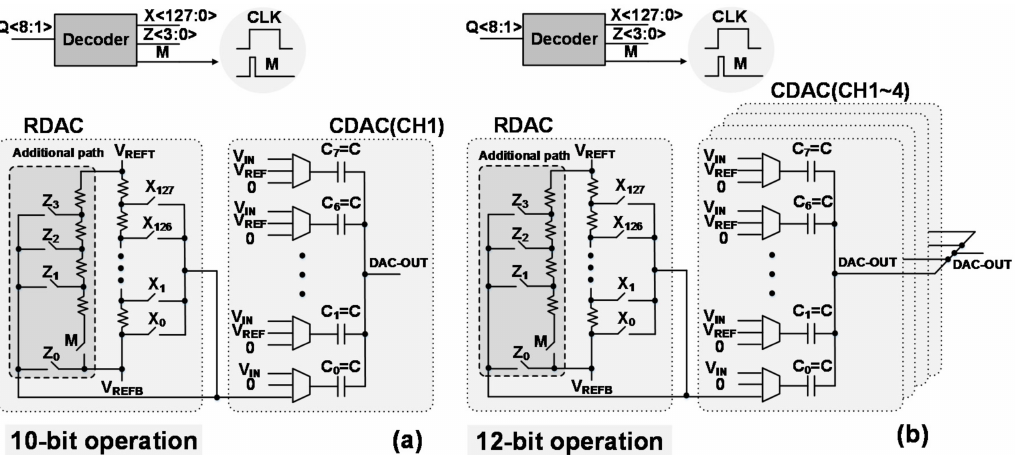
Figure 4. Simplified CDAC (capacitor digital-to-analog converter) and RDAC (resistor digital-to-analog converter) structures and their combinations for ( a ) 10-bit; ( b ) 12-bit